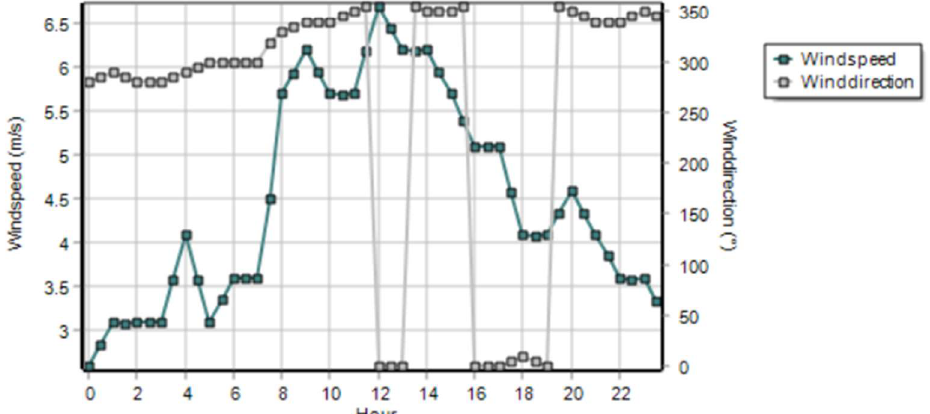
Figure 5. Full forcing boundary conditions for the ENVI-met depicting direct shortwave, diffuse shortwave, and longwave radiation (top graph), potential air temperature and specific air humidity (middle graph) as well as wind speed and wind direction (bottom graph) on the 23 May.